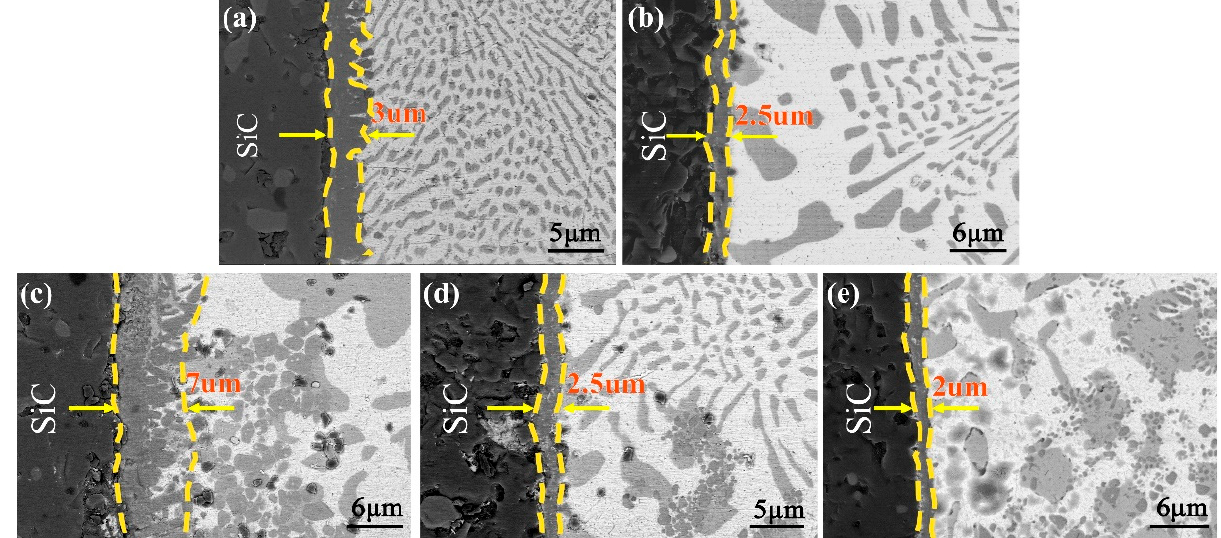
Figure 12. Local enlargement of typical interface of AgCuTi composite brazing filler brazing SiC joints at 900 °C for 10 min; ( a – e ) LAS additions of 0 wt%, 0.5 wt%, 1 wt%, 2 wt%, and 3 wt%, respec- tively. The joint shear strength of AgCuTi + 1 wt% LiAlSiO 4 with different holding times at